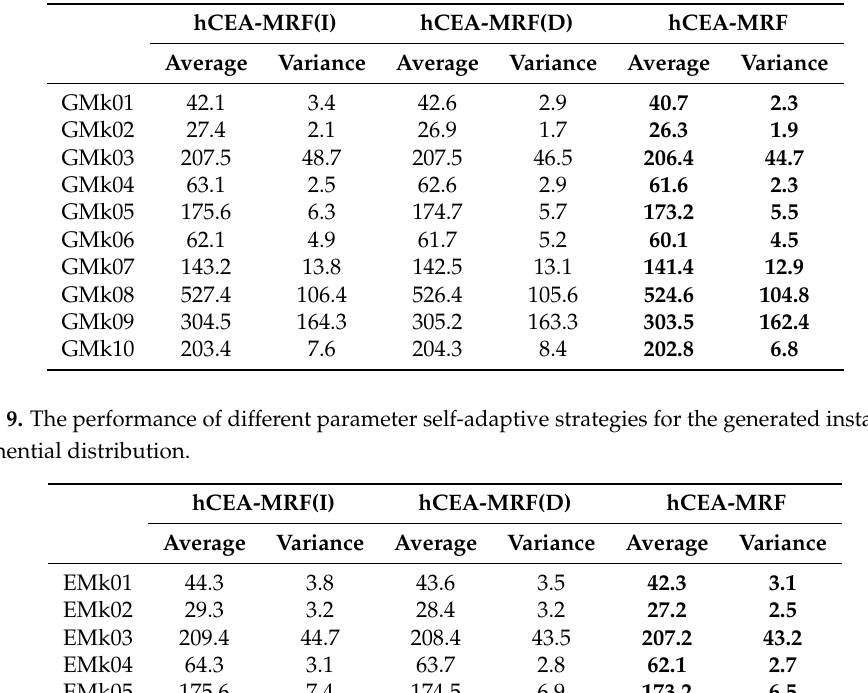
Table 8. The performance of different parameter self-adaptive strategies for the generated instances by Gaussian distribution.